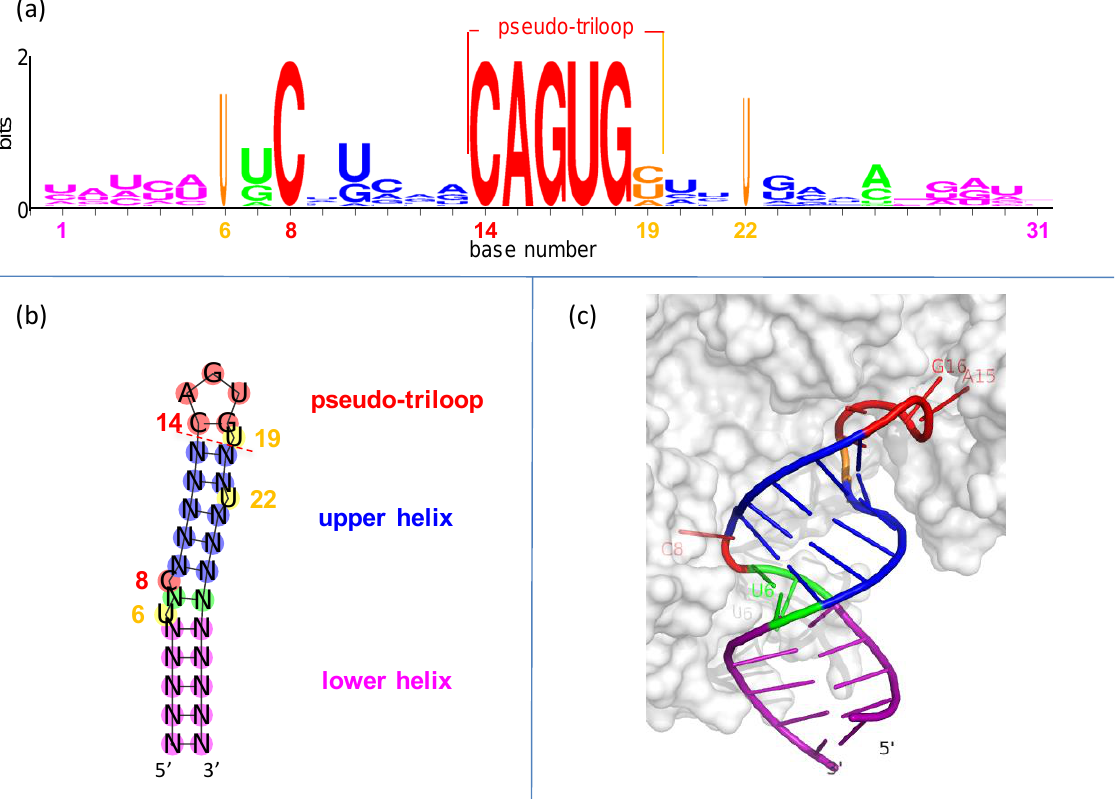
Figure 2. Conservation and structure in iron responsive elements (IREs). ( a ) IRE representation in seq-logo format [37]. Sequences are from Table S1. Symbol height shows the conservation at each position, while widths are proportional to the fraction present. ( b ) Secondary structure of hypothetical IRE with conventional number scheme as in ( a ). ( c ) Representative three-dimensional structure of IRE in complex with iron regulatory protein-1 (IRP1) [38]. The only bases making sequence-specific contacts with the IRP1 protein are C 8 ( middle left ), and A 15 , G 16 , and U 17 ( upper right